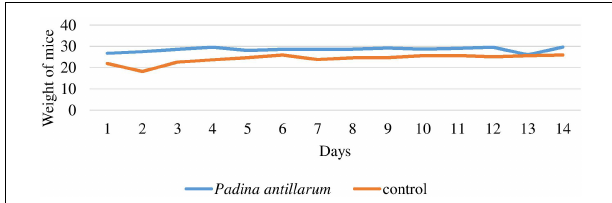
FIGURE 9 | Weight of mice with reference to control